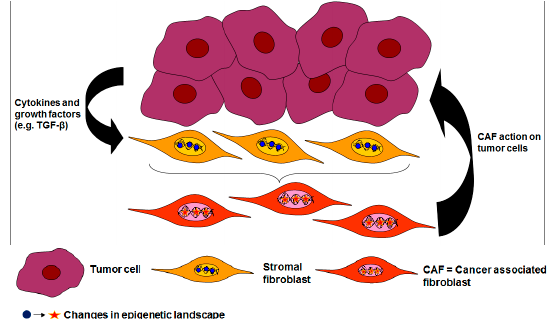
Figure 1. New epigenetic marks are imposed on normal stromal fibroblasts by neighboring cancer cells reshaping their epigenetic landscape. Cancer-derived cytokines such as TGF- β 1 are involved in this process. The altered epigenetic signature accounts for the durable phenotype of cancer-associated fibroblasts (CAFs). Once corrupted to CAFs, stromal fibroblasts support the relentless growth and invasive program of the cancer cells. Note the vicious, self-perpetuating sequence of events that propagate and maintain the malevolent liaison between cancer cells and